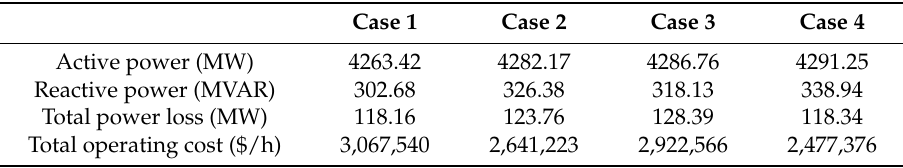
Table 4. Detailed results for each case in the modified IEEE-118 bus system.